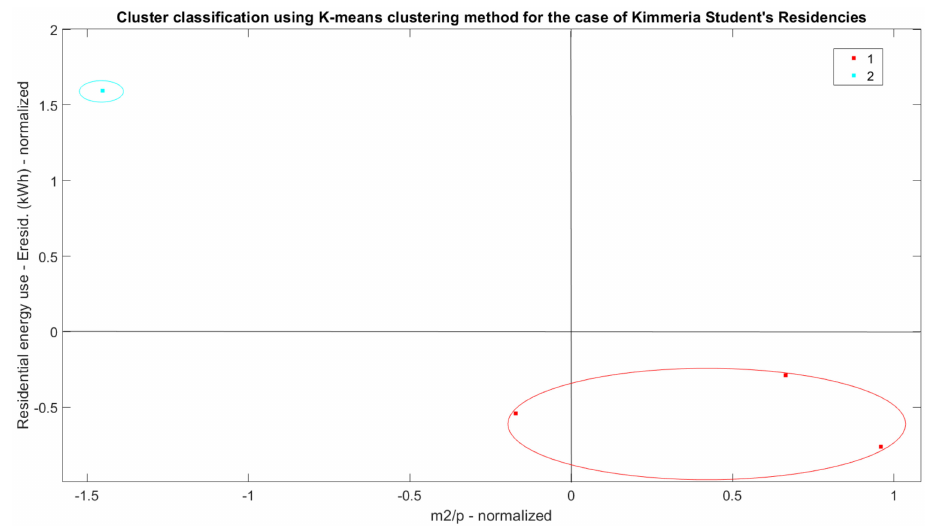
Figure 3. Cluster classification using k-means clustering methodology for the case of students’ residences in Kimmeria,